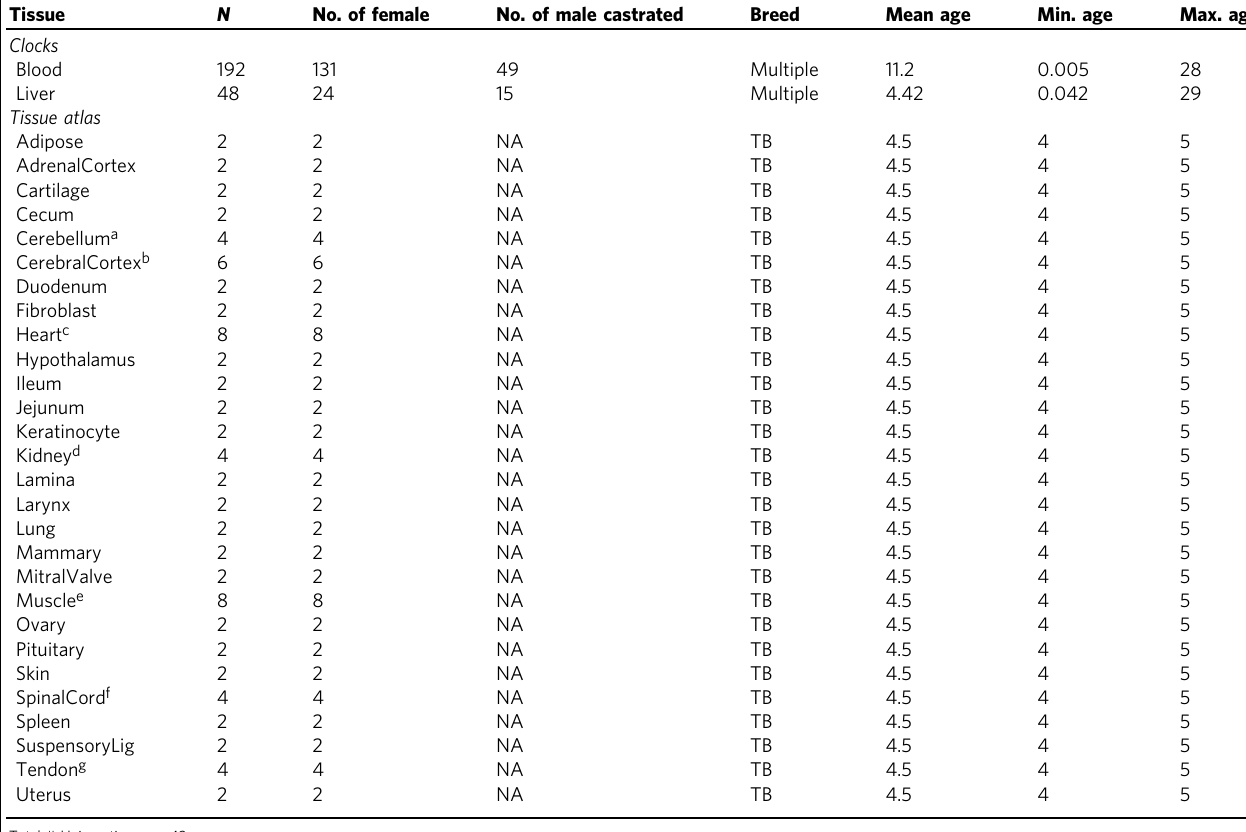
Table 1 Description of blood methylation data.